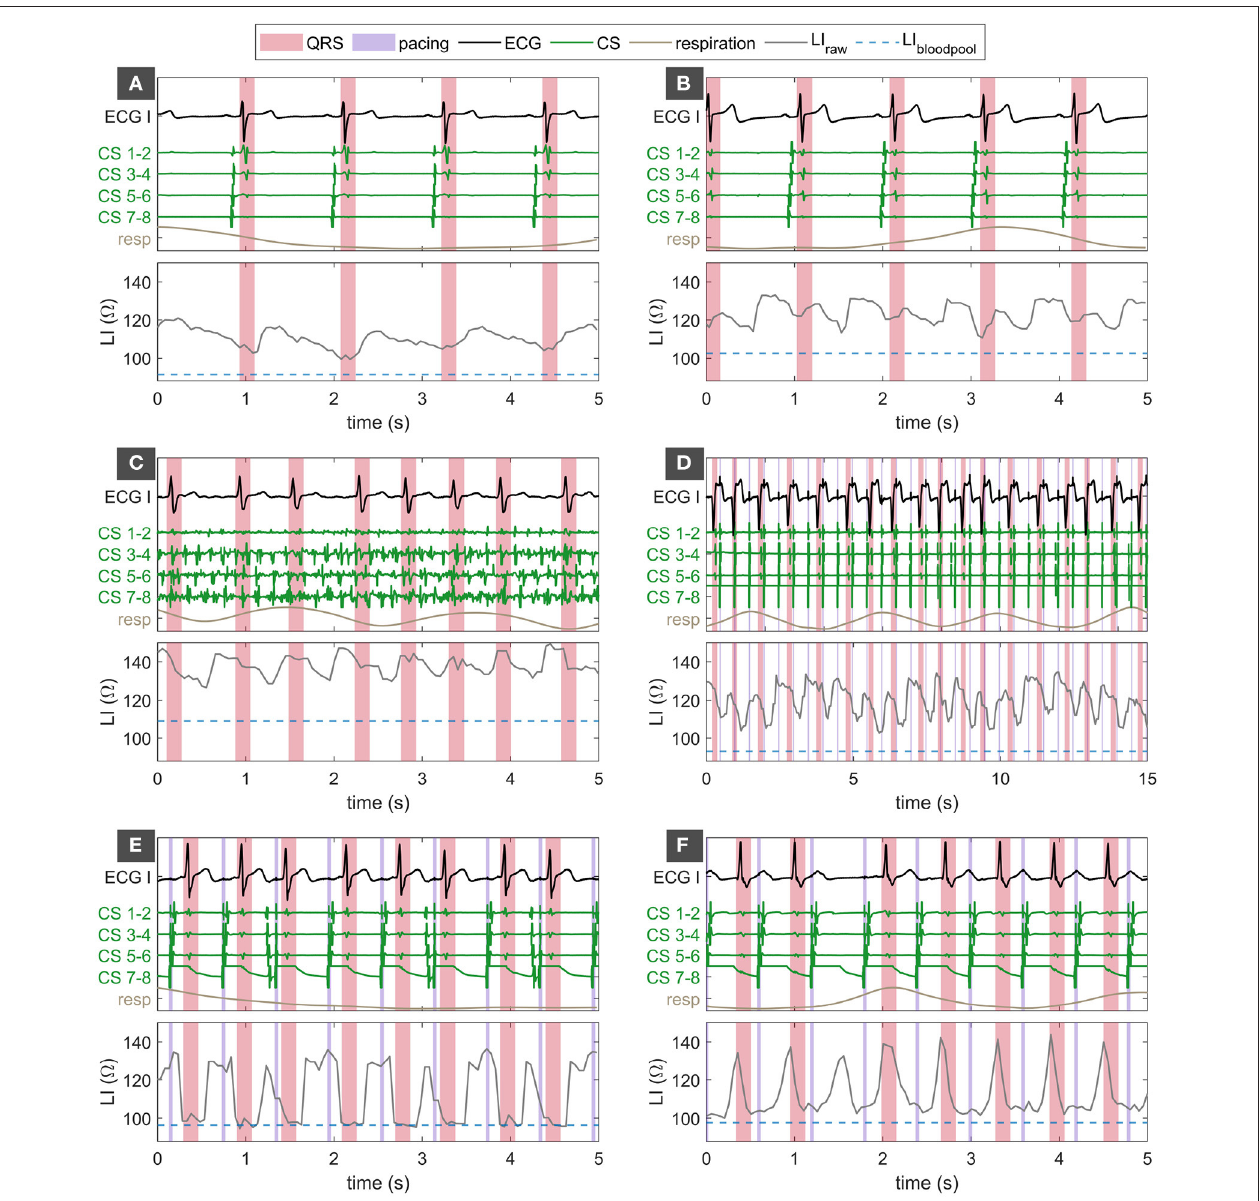
FIGURE 8 | Panels (A–F) show different examples of oscillatory amplitudes, morphologies, and dependencies in LI raw . Traces of LI raw in the respective lower panel in gray along with the corresponding bipolar CS electrograms in green, Einthoven lead I in black, and the respiratory phase in brown in the respective upper panel. LI bloodpool is given as a broken blue line in the lower panel. QRS complexes are shaded in red. Pacing events are shaded in violet. LI, local impedance; ECG, surface electrocardiogram; ECG I, Einthoven lead I of the ECG; CS, coronay sinus.